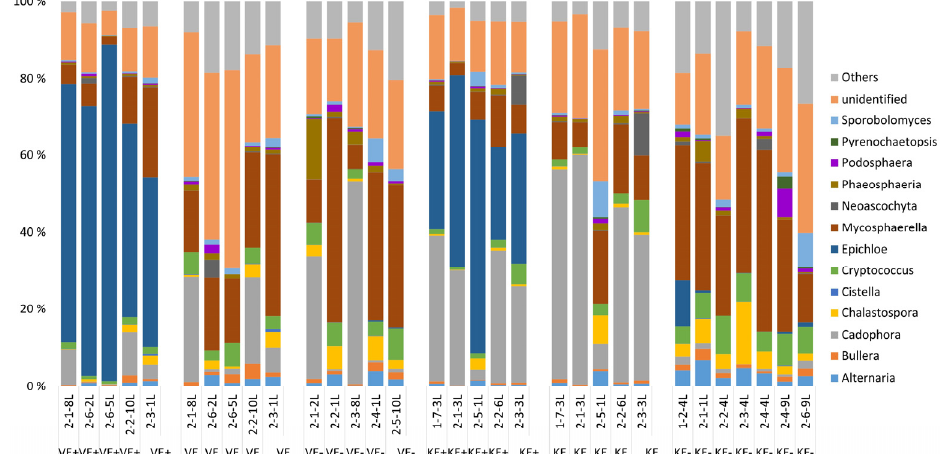
Figure 2. Taxonomic distribution of fungal communities at the genus level in leaves of Epichloë - symbiotic (E+) and Epichloë -free (E-) plants of ‘Valtteri’ (V) and ‘Kasper’ ('K) cultivars of meadow fescue ( Festuca pratensis ). For each cultivar, the X -axis shows taxonomic distribution in E+ plants for total fungal communities (E+), fungal communities in E+ plants after depletion of Epichloë taxa (E) and fungal communities in E- plants (E-).